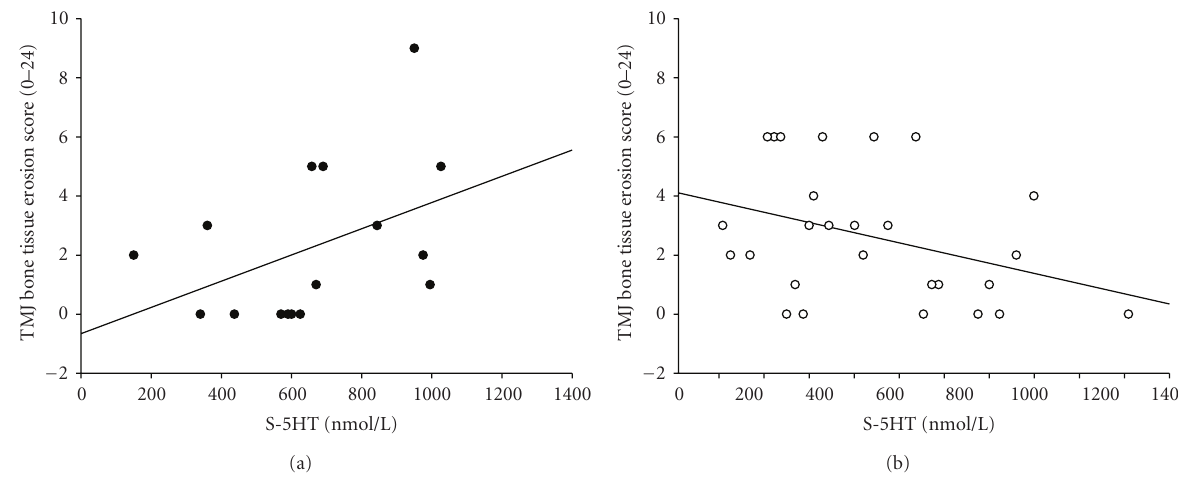
Figure 2: Scatter plots showing (a) the relationship between serum level of serotonin and temporomandibular joint (TMJ) bone erosion score in the male patients ( r s = 0 . 54, n = 16, P = . 031) and (b) in the female patients ( r s = − 0 . 34, n = 27, P = . 080). • : males, ◦ : females.